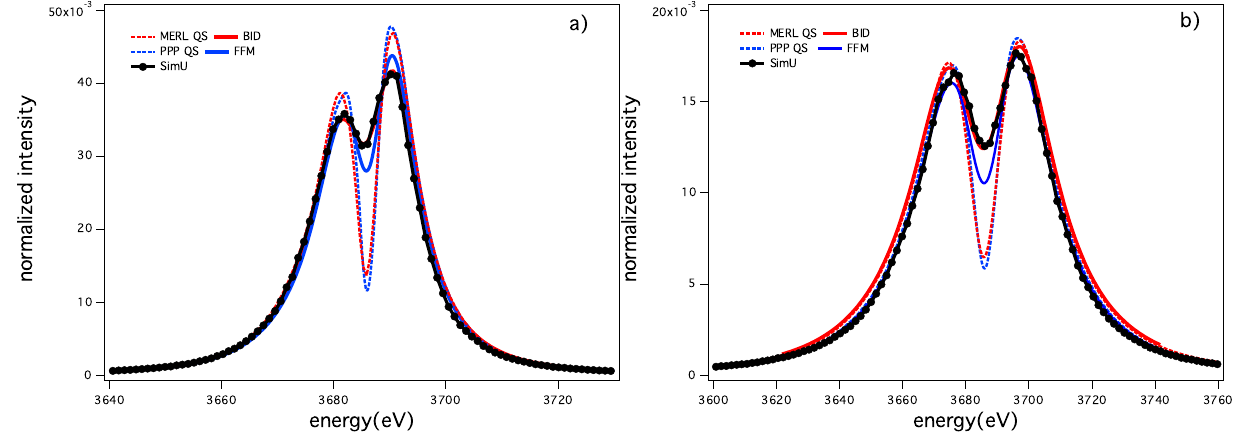
Figure 11. The He- (cid:12) line for T = 1 keV and ( a ) n Static ions: MERL (red dot), PPP (blue dot); SimU (black dot); BID (solid red); FFM (solid